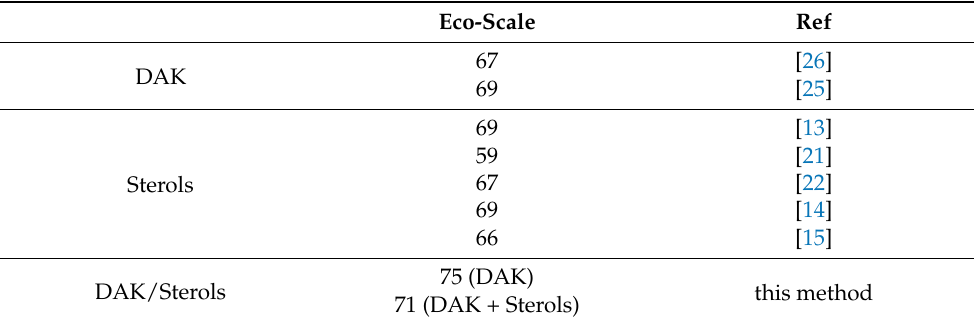
Table 2. Comparison of the proposed method vs. other methods reported in the literature based on the Eco-Scale system [31]. Eco-Scale Ref 67 DAK